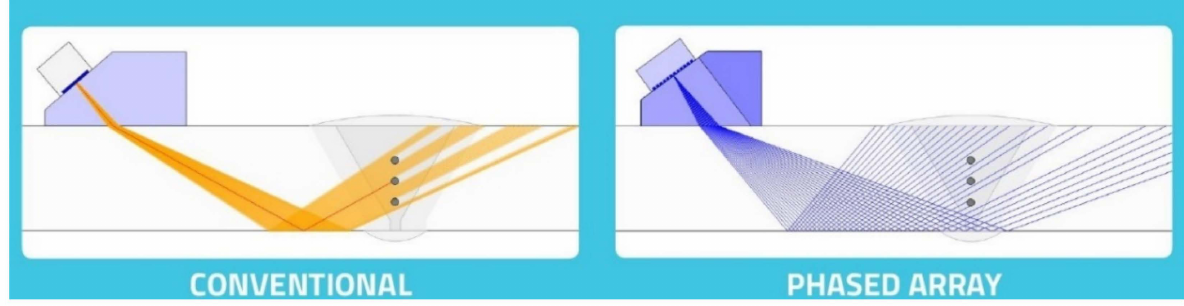
Figure 12. Comparison between conventional UT and phased-array UT, where PAUT allows for the shaping and steering of the ultrasonic beam angles, better depth focus, and enhanced coverage